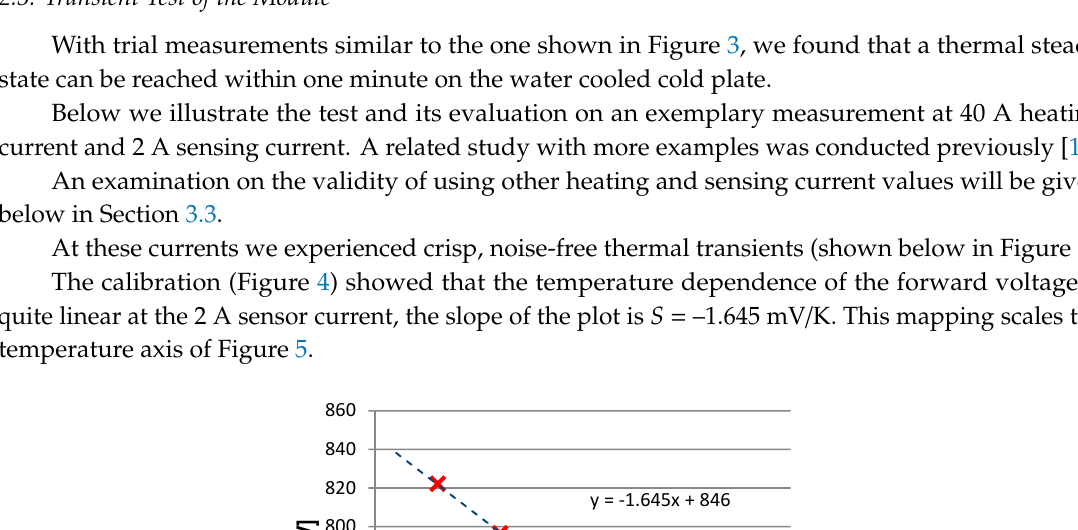
Figure 3. Transient change of the V F forward voltage on a thyristor in the module of Figure 2 during cooling at different sense current levels.